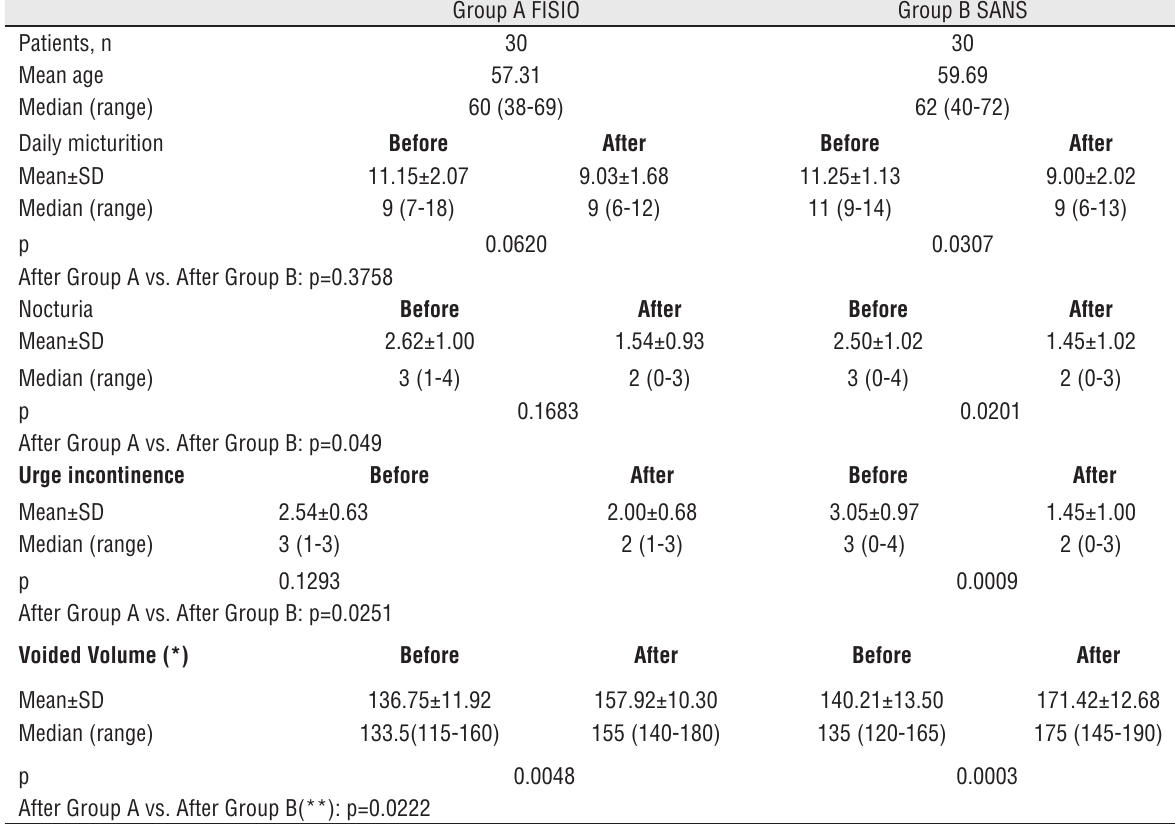
Table 1 - 3-day micturition